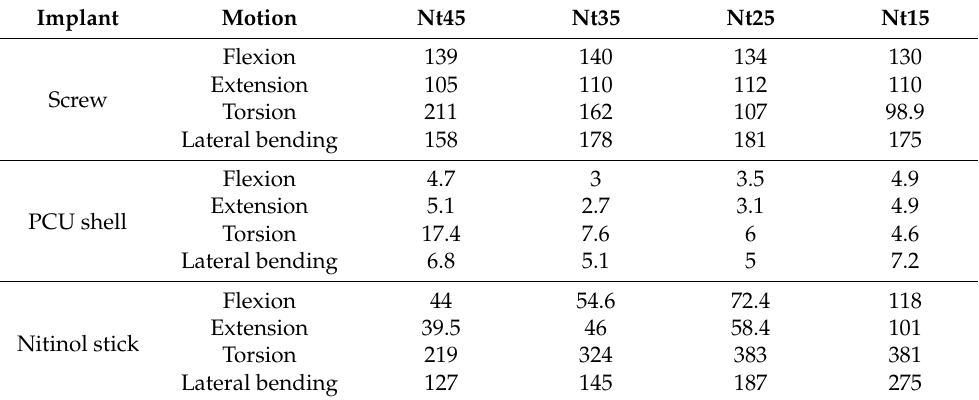
Table 7. Comparison of the maximum von Mises stress on rods (MPa) in finite element models. There was no obvious trend in outer PS stress as the NS diameter changed. The stress on the inner nitinol stick increased as the NS diameter